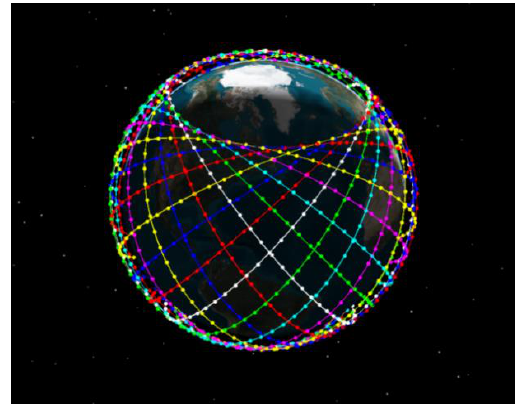
Figure 5. 3D simulation